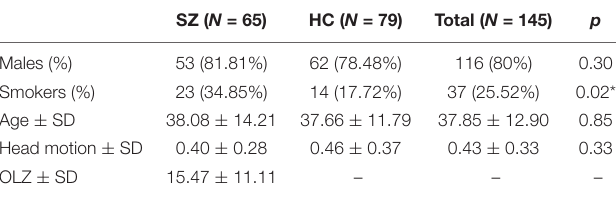
TABLE 1 | Participant demographic